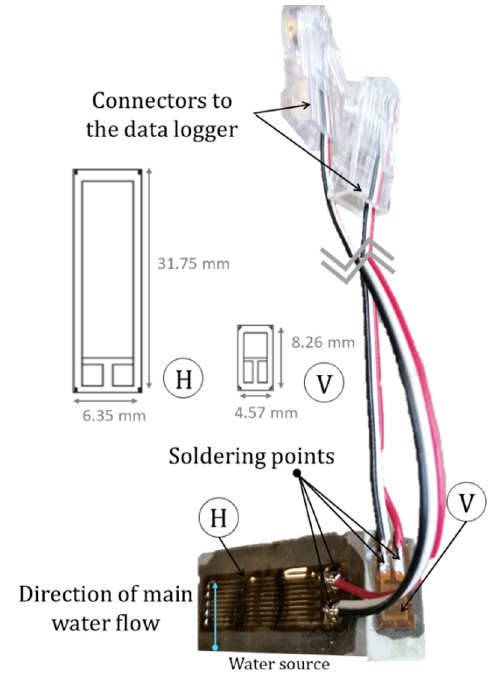
Figure 2. Paste specimen with the attached strain gauges and soldered cable connections (H = hori- zontal strain gauge, V = vertical strain